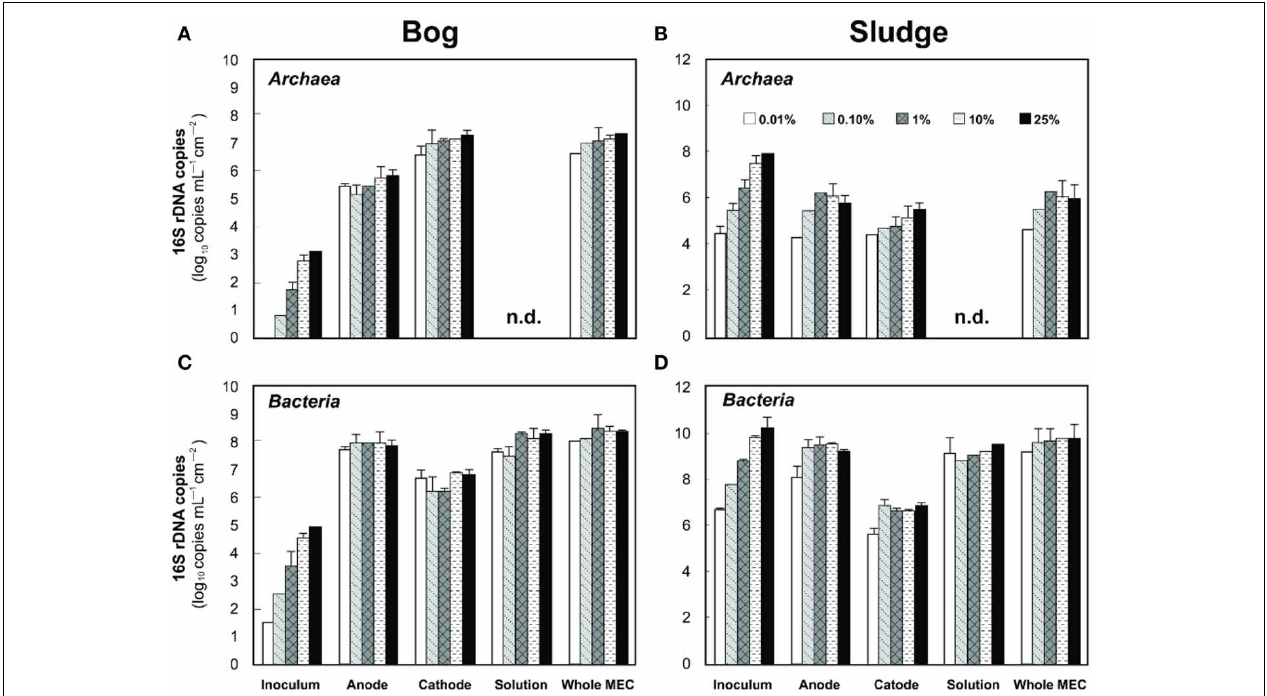
FIGURE 6 | Left (A,C), copy numbers of Archaea (A) and Bacteria (C) populations in anodes, cathodes, and solutions of freshwater bog MECs. Right (B,D) , copy numbers of Archaea (top) and Bacteria